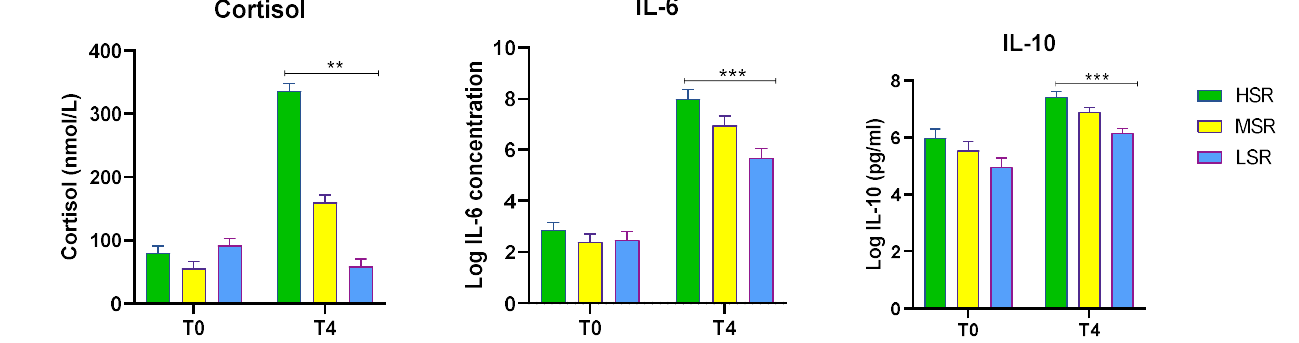
Figure 1. Basal (T0) and 4 h (T4) concentrations of serum cortisol, IL-6, and IL-10 in sheep before and after LPS (400 ng/kg) i.v . administration. Animals were classified as high (HSR), middle (MSR), or low (LSR) based on their T4 cortisol concentrations. Values are presented as means ± SEM. Significant differences are shown by asterisks (** p ≤ 0.01 and *** p ≤ 0.001) compared with the T0 (basal) levels.